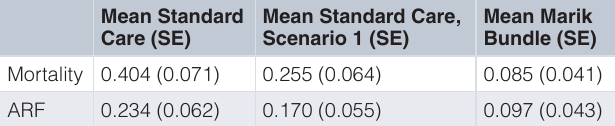
Table 1. Transition probabilities from bundle decision to survival and